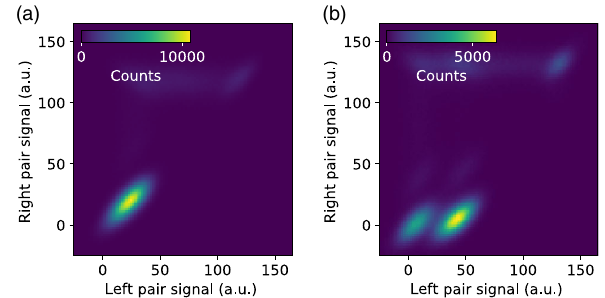
FIG. 8. Histograms of correlated left- and right-pair readout directly after initialization of (a) the singlet-singlet product state and (b) the triplet-singlet product state. For both the left- and the right-pair readout, the integration time is 8 μ s, and the bin width is [1.9, 1.9] a.u.